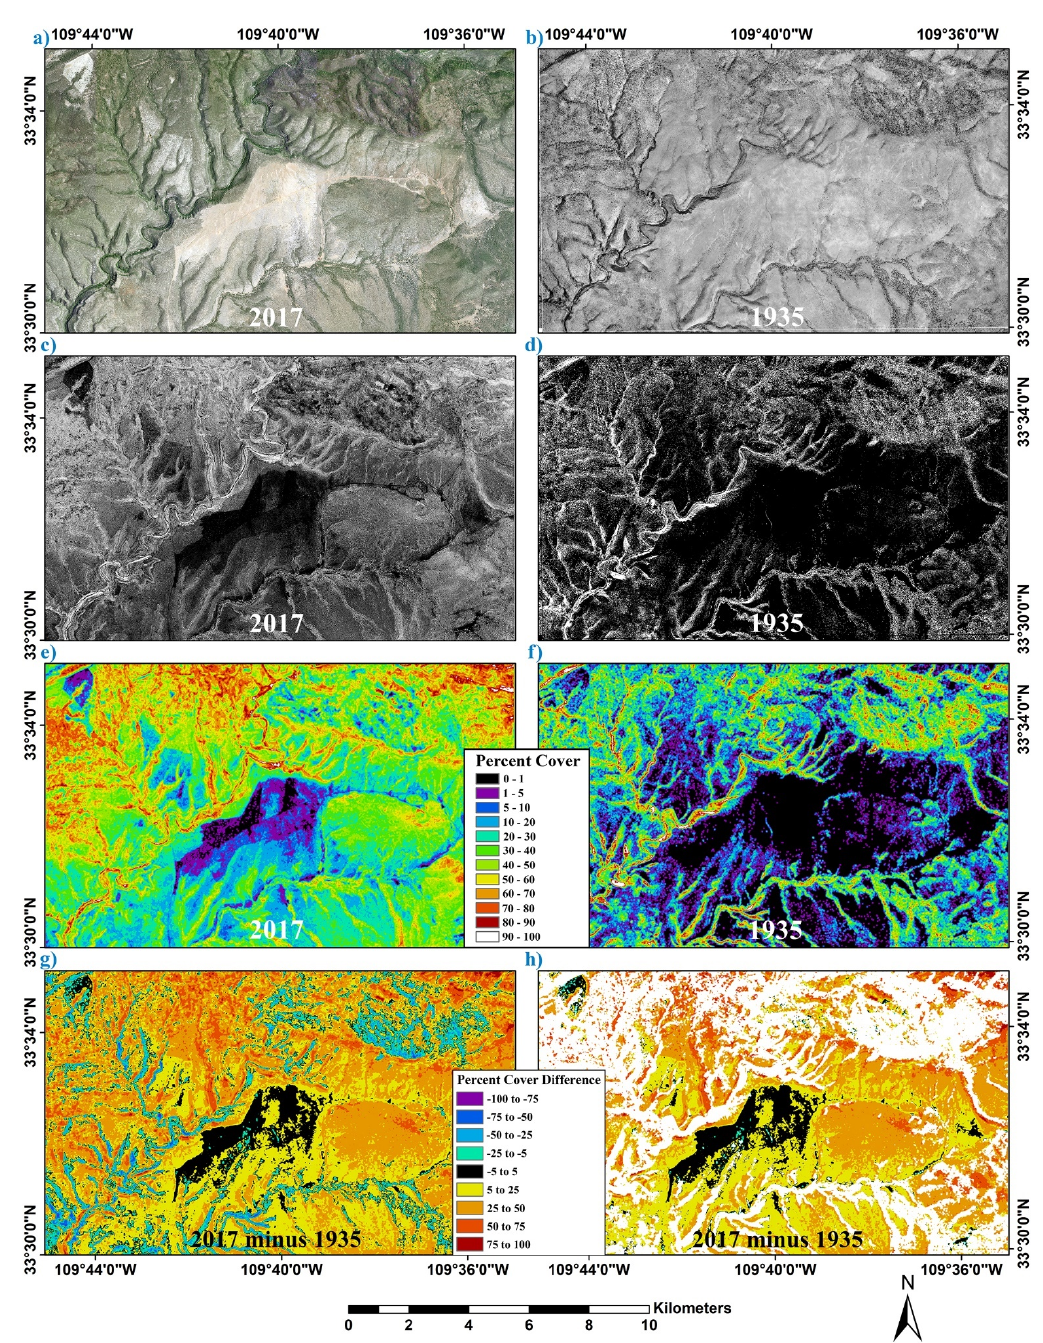
Figure 6 . Image maps for Bee Flat study area. ( a ) “True color” image for 2017 (2017 NAIP aerial imagery). ( b ) Panchromatic image represents a processed, digitized mosaic of aerial photographs taken in 1935. ( c ) Tree/large shrub canopy map for 2017. Seen at this coarse display resolution, the white and black pixels combine into shades of gray roughly portraying a density gradient. ( d ) Tree/large shrub canopy map for 1935. ( e ) Tree/large shrub percent cover map for 2017. ( f ) Tree/large shrub percent cover map for 1935. ( g ) Tree/large shrub percent cover difference map (2017 minus 1935). ( h ) Tree/large shrub percent cover difference map with woodland (and forest) areas greater than 15% canopy cover in 1935 masked in white. Therefore, this image portrays the change in percent cover units for savanna and grassland areas mapped in